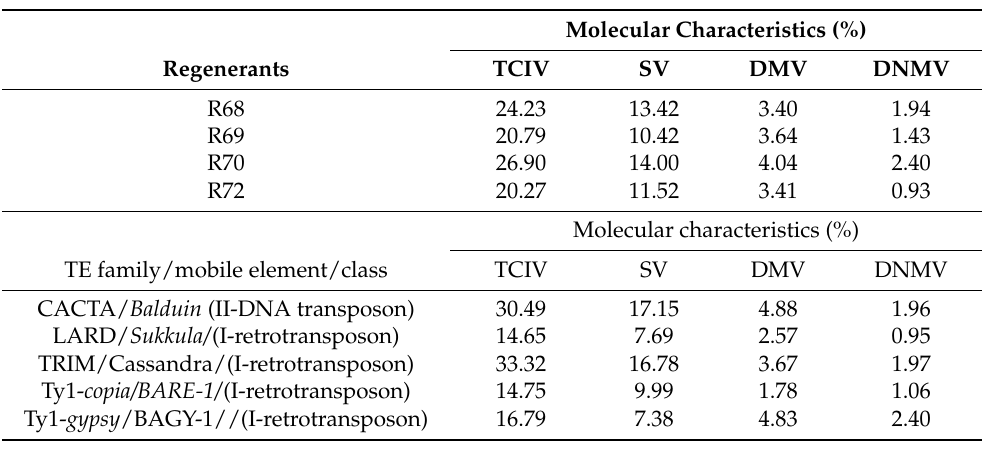
Table 2. The MSTD characteristics related to regenerants (R68–R72) obtained from various donor plants and analyzed within different TE families (TE).